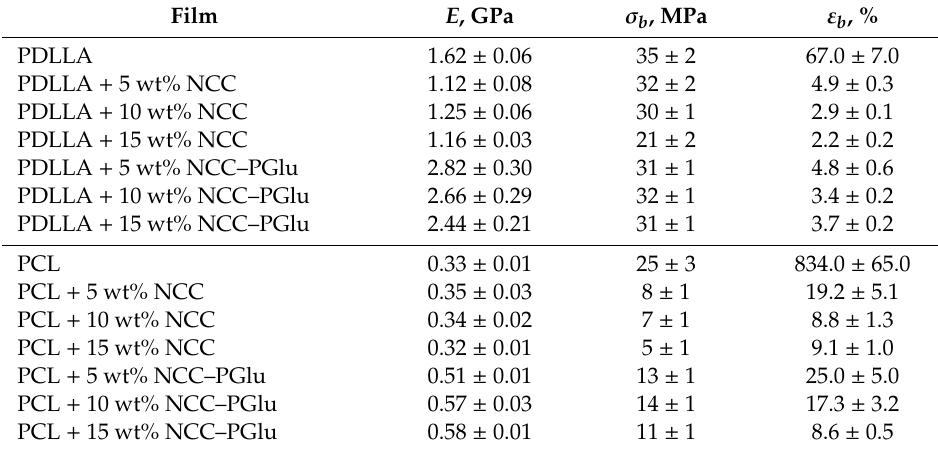
Table 2. Mechanical properties of pure and NCC and NCC–PGlu filled films (based on PDLLA and